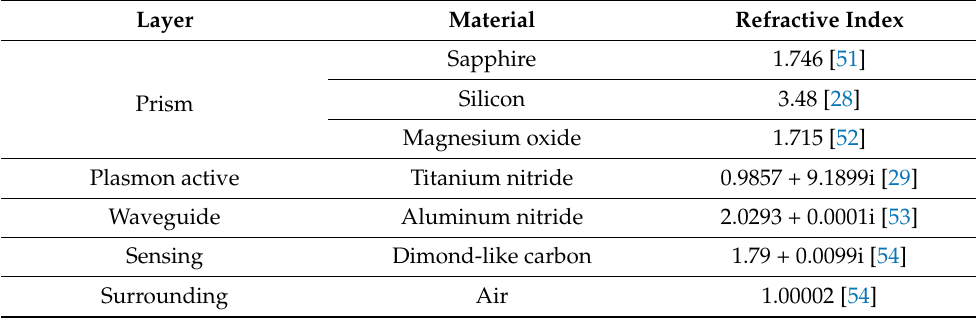
Table 1. Summary of parameters used for simulation the CPWR sensors at 1550